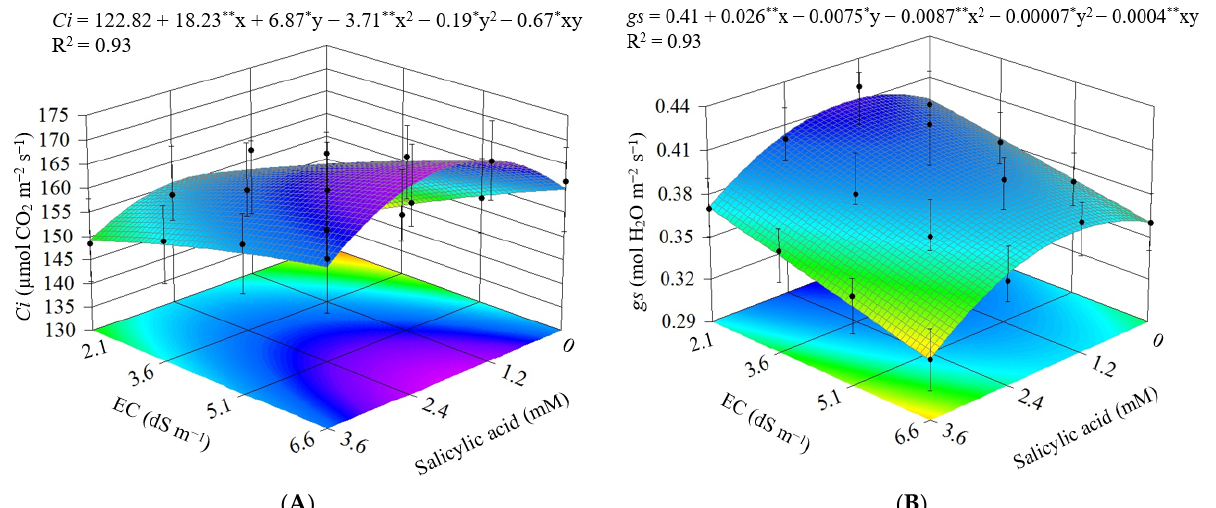
Figure 3. Relative water content—RWC of ‘Canindé’ okra cultivated in a hydroponic system as a function of the electrical conductivity of the nutrient solution (EC) 60 days after transplanting. ** Significant at p ≤ 0.01. The vertical lines represent mean +/ − standard error (n = 4). All variables of leaf gas exchange were significantly influenced ( p ≤ 0.01) by the in- tion of salicylic acid (EC × SA); the saline nutrient solution isolated also affected all var- iables except internal CO 2 concentration and stomatal conductance while no variables were influenced by the application of salicylic acid. The increase in the electrical conductivity of the nutrient solution increased the internal CO 2 concentration, regardless of the salicylic acid concentration (Figure 4A). It was also verified that the application of salicylic acid up to 1.9 mM increased internal CO 2 concentra- tion, whose highest value (172.73 µ mol CO 2 m − 2 s − 1 ) was obtained in plants grown under EC of 6.6 dS m − 1 and sprayed with SA at the concentration of 1.9 mM, corresponding to an increase of 8.0% (12.84 µ mol CO 2 m − 2 s − 1 ) compared to plants irrigated with the same EC (6.6 dS m − 1 ) and without application of SA (0 mM).